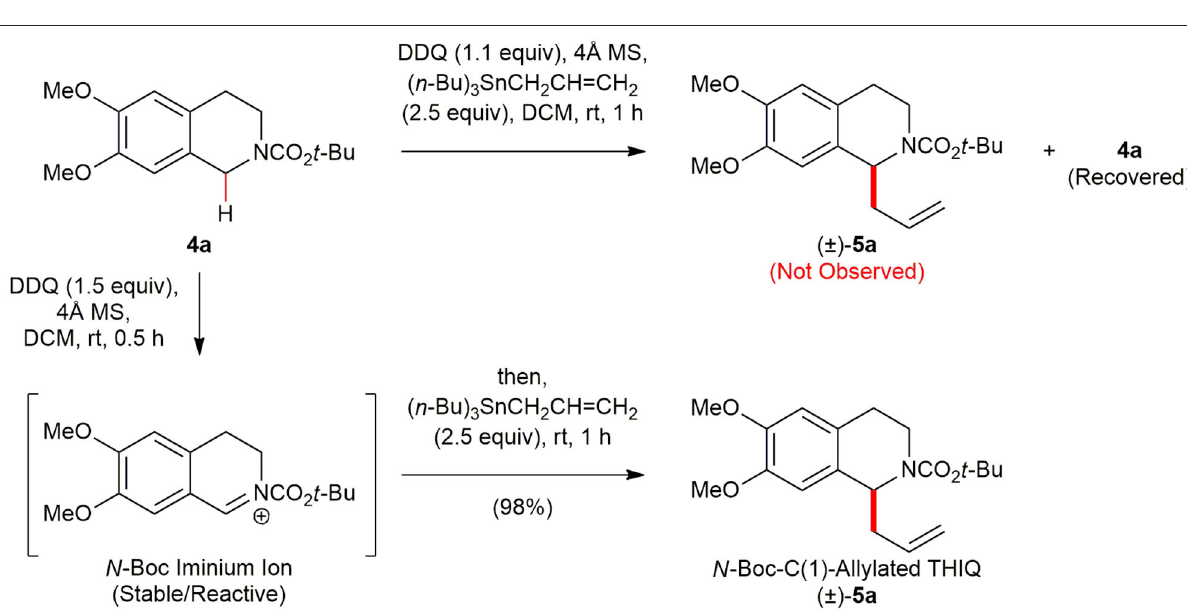
FIGURE 1 | Selected biologically active natural products embodying C(1)-substituted 1,2,3,4-tetrahydroisoquinoline (THIQ)